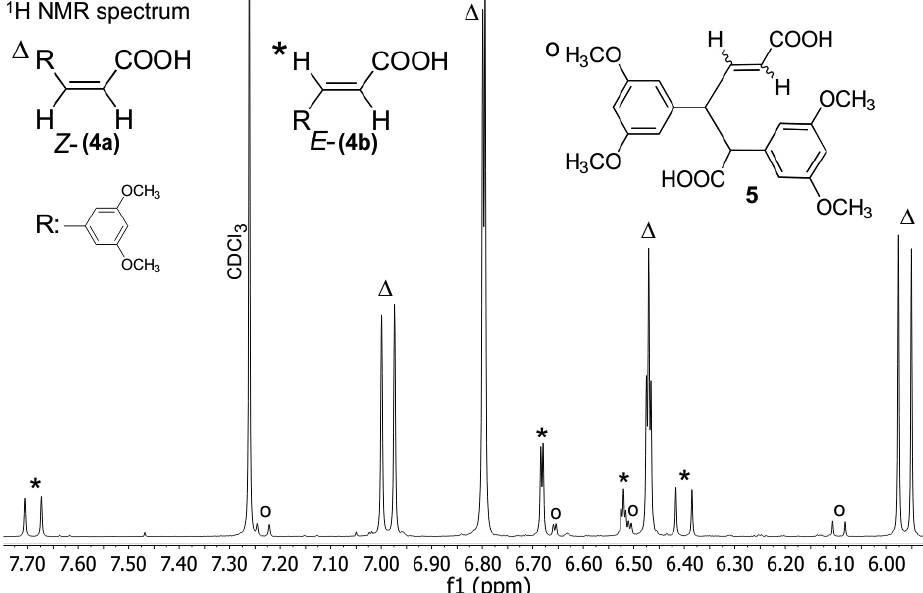
Figure 5. 1 H NMR spectrum of the residue obtained after 2 hours UV-irradiation at 360 nm of 1.2 × 10 –3 M acetonitrile solution of E -dimethoxycinnamic acid.